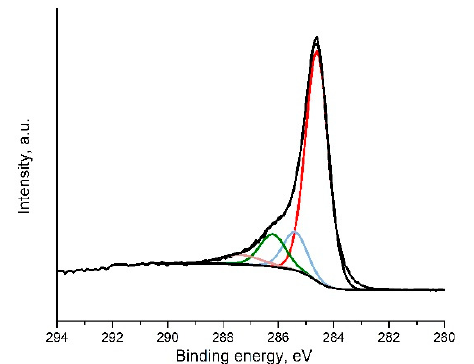
Figure A4. C1s spectra (XPS) of thermally reduced graphene oxide TRGO2.